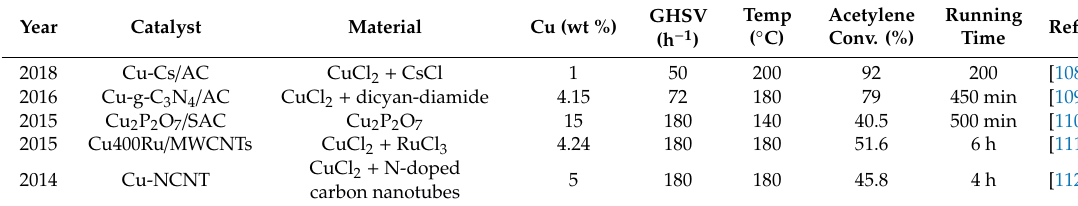
Table 5. Performance of Cu catalysts for acetylene hydrochlorination.